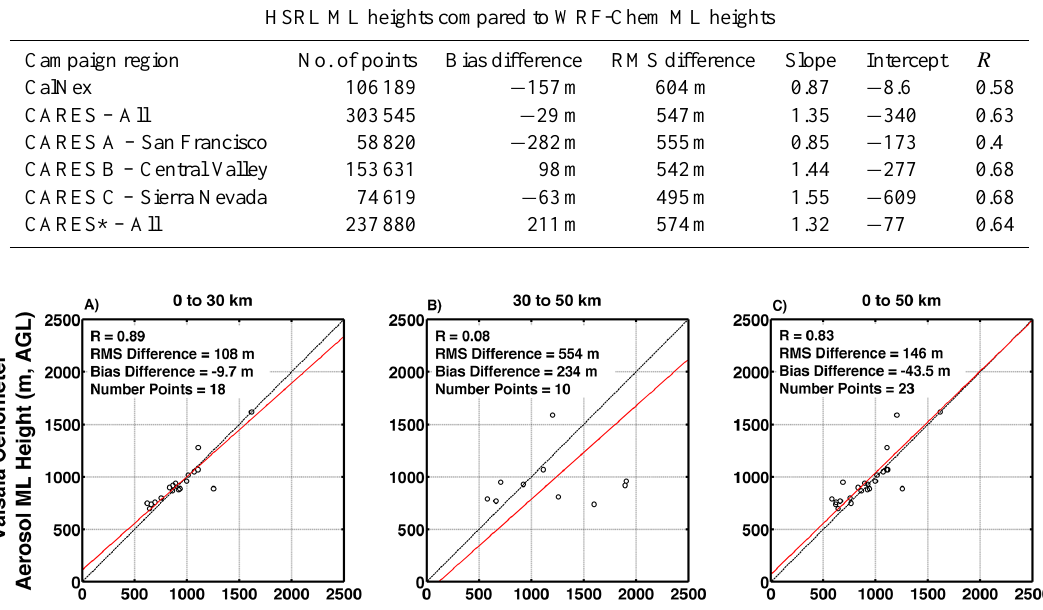
Table 4. Statistics of the HSRL aerosol ML and WRF-Chem thermodynamic ML height comparisons for CalNex and CARES. The CARES ∗ statistics are from the HSRL and WRF-Chem aerosol ML height comparisons. The bias difference and RMS difference are calculated by WRF-Chem minus HSRL. The number of points in these comparisons corresponds to the HSRL resolution of the backscatter profiles (1 point ≈ 1km of airborne HSRL data).